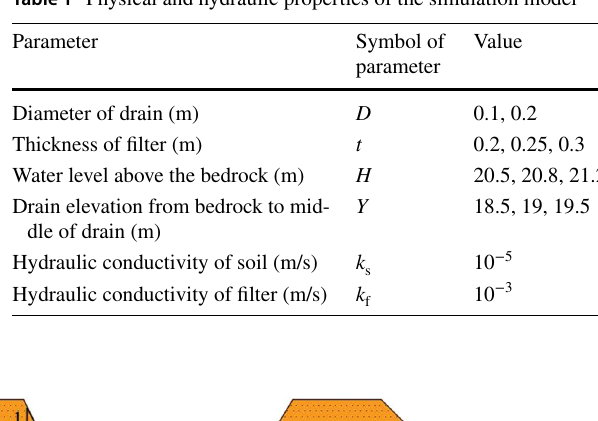
Fig. 3 Cross section of solution domain